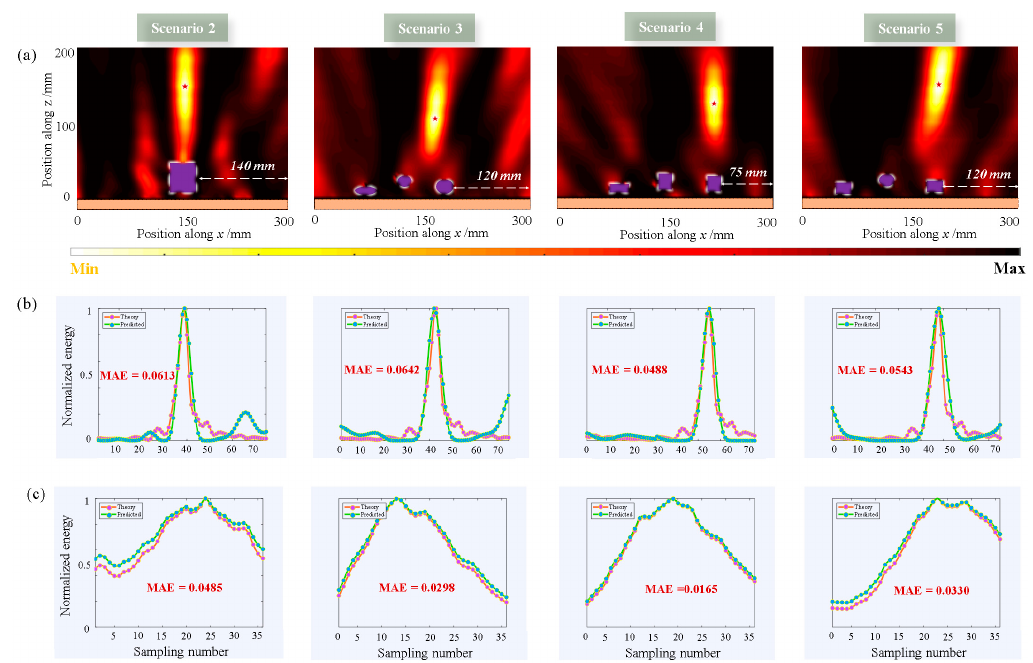
Figure 6. Focusing results for different scenarios. ( a ) Two-dimensional focusing results for different scenarios under normal incidence. Red five-point star represents the position of the target focus. ( b ) Network prediction and theoretical results of Data 1 under different scenarios, and the MAE loss was calculated. ( c ) Network prediction and theoretical results for Data 2 under different scenarios.